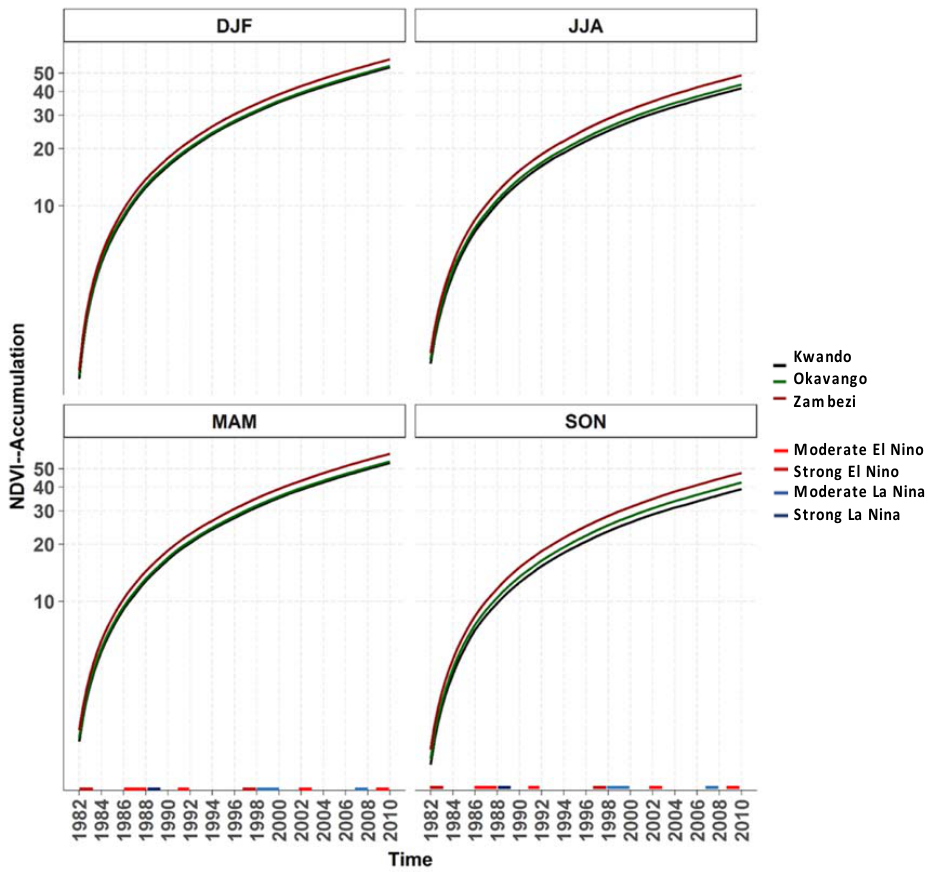
Figure 7. Cumulative NDVI across each season (DJF, JJA, MAM, and SON) for the three drainage basins in the study area.